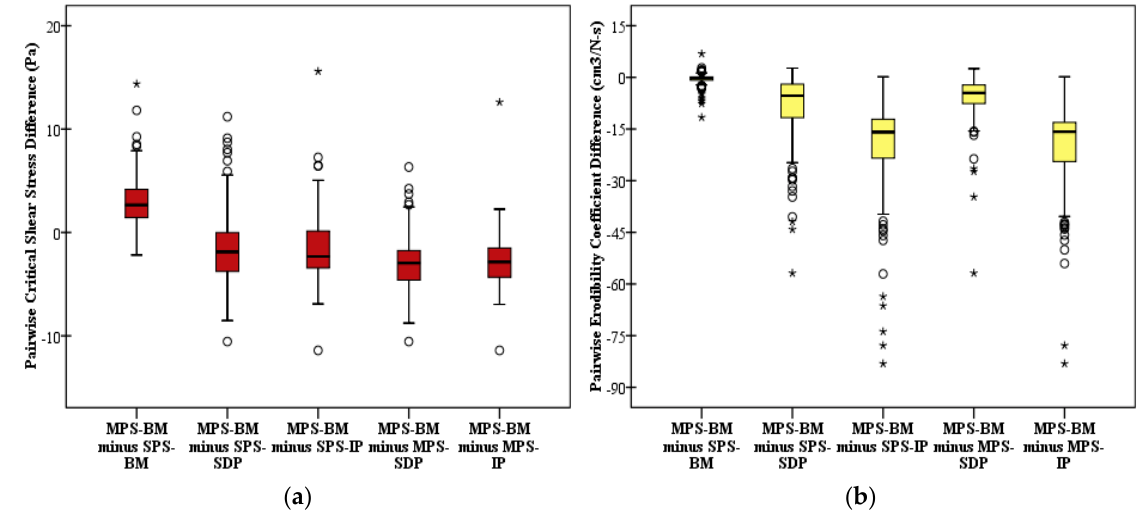
Figure 9. Pairwise differences between different solution techniques for: ( a ) critical shear stress ( τ c ), and ( b ) erodibility coefficient ( k d ) estimations between: MPS-BM and SPS-BM; MPS-BM and SPS-SDP; MPS-BM and SPS-IP; MPS-BM and MPS-SDP; and MPS-BM and MPS-IP procedures.